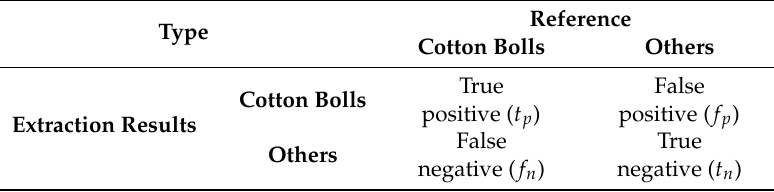
Table 2. Error matrix for the accuracy assessment of cotton boll